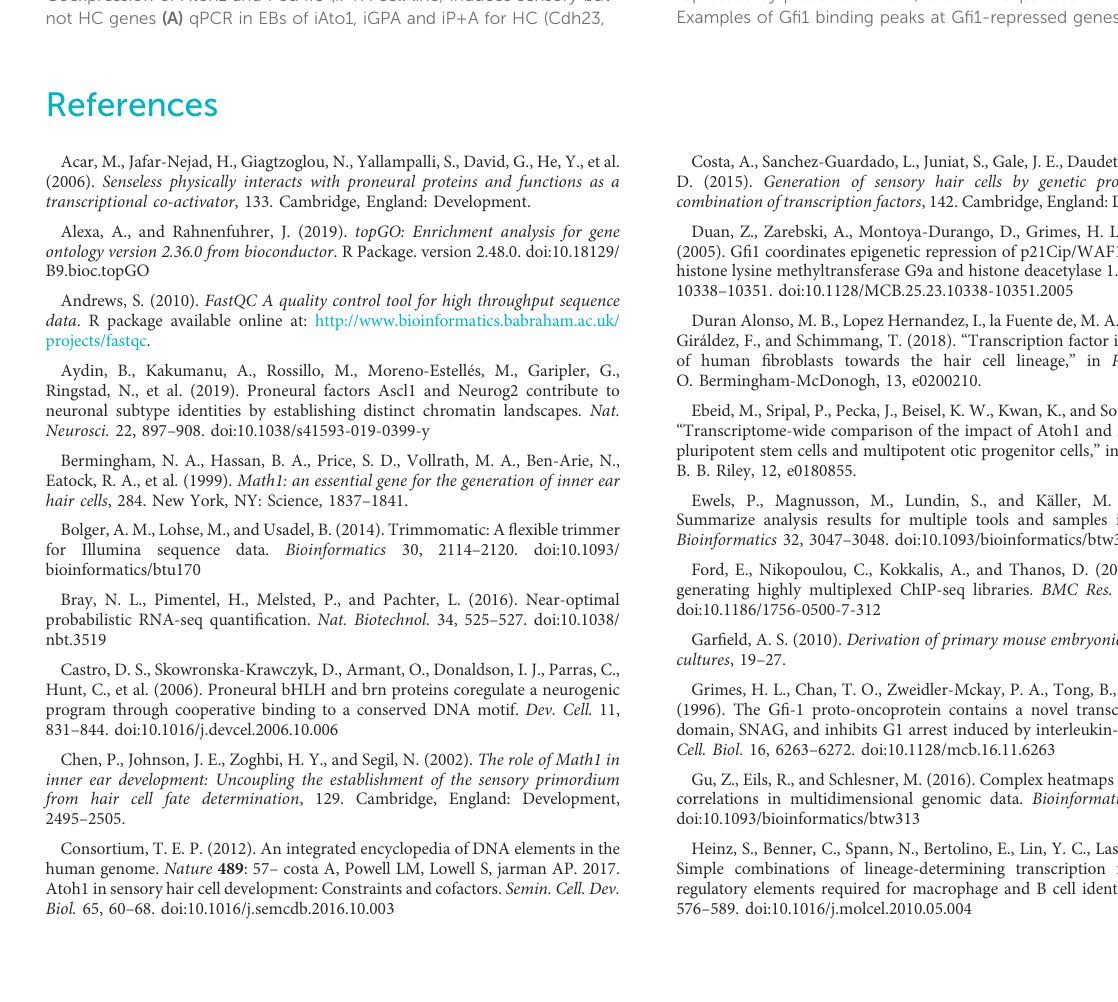
Direct binding of Atoh1 and Pou4f3 to a subset of genomic locations (A) de novo sequence motifs enriched in Atoh1/Pou4f3 co-bound peaks from iGPA cells (middle) compared with peaks bound only by Atoh1 (upper) or Pou4f3 (lower). (B) Atoh1 and Pou4f DNA motifs associated with Atoh1 and Pou4f3 binding peaks.